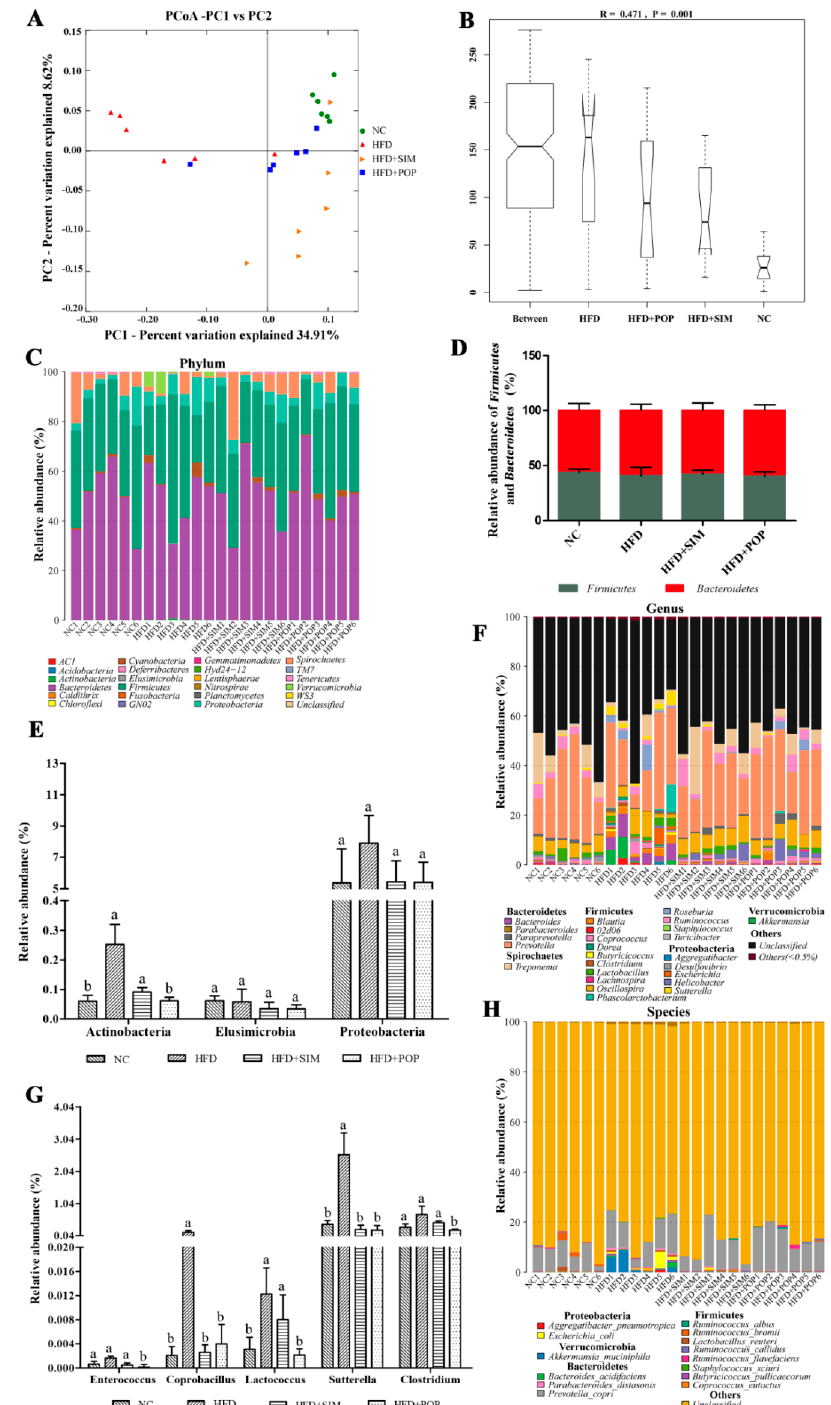
Figure 6. POP treatment regulated gut microbiota structure in HFD-fed obese rats. ( A ) UniFrac-based PCoA plots. ( B ) Analysis of similarity (ANOSIM) among groups based on the Bray–Curtis distances. ( C ) Relative abundances of gut microbiota at the phylum level. Relative abundances of ( D ) major phyla Firmicutes and Bacteroidetes and ( E ) minor phyla Actinobacteria , Elusimicrobia , and Proteobacteria . Relative abundances of gut microbiota at the ( F ) genus and ( H ) species levels. ( G ) Relative abundances of minor genera Enterococcus , Coprobacillus , Lactococcus , Sutterella , and Clostridium . All data are presented as means ± SEM. a,b Mean values not sharing a common superscript were significantly different among the groups ( n = 6 for each) ( p <